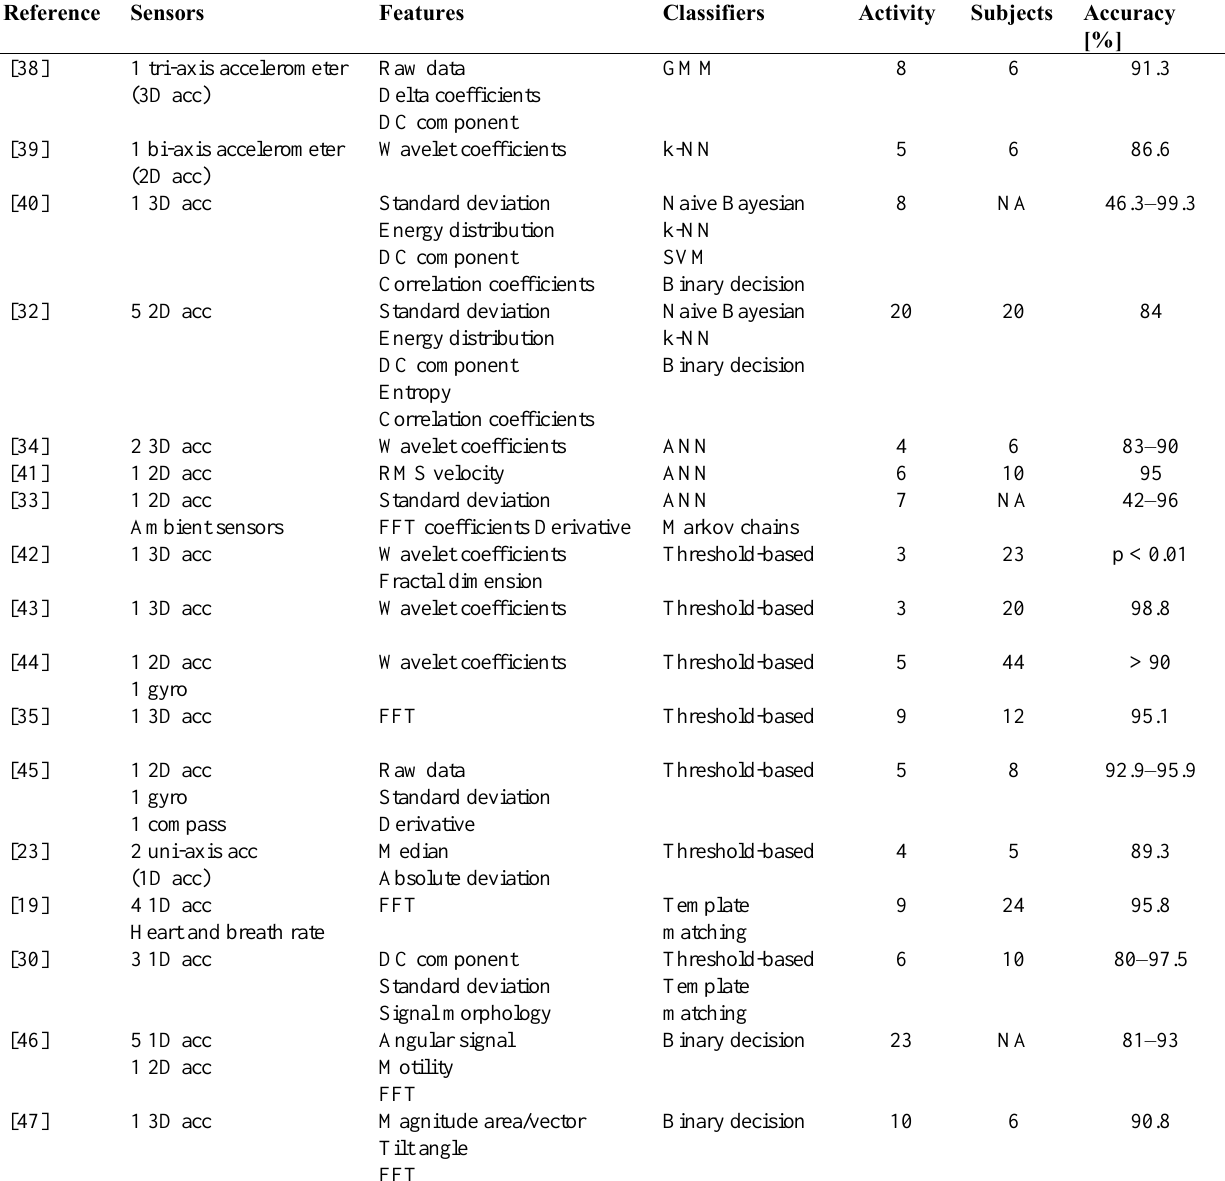
Table 1. State of the art of human motor activity classification